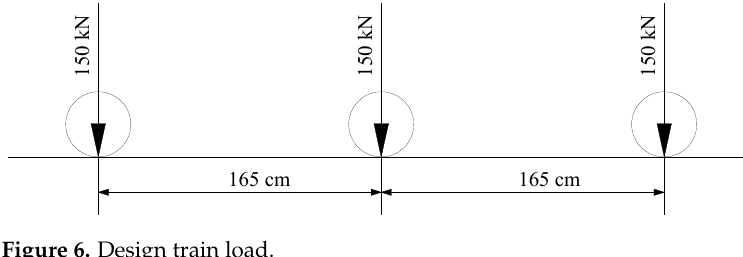
Figure 6. Design train load.